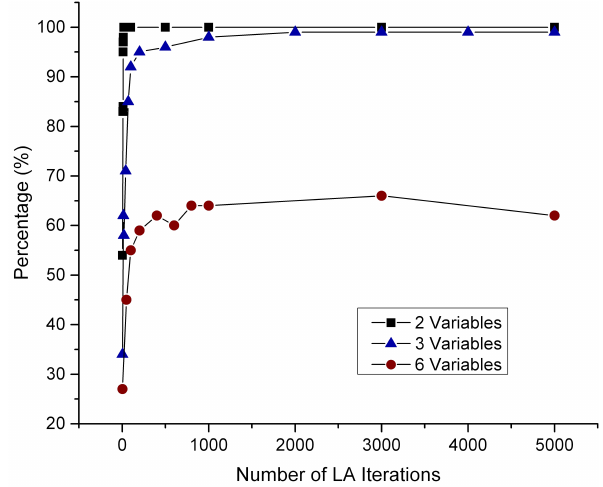
Figure 4. Performance of Orion